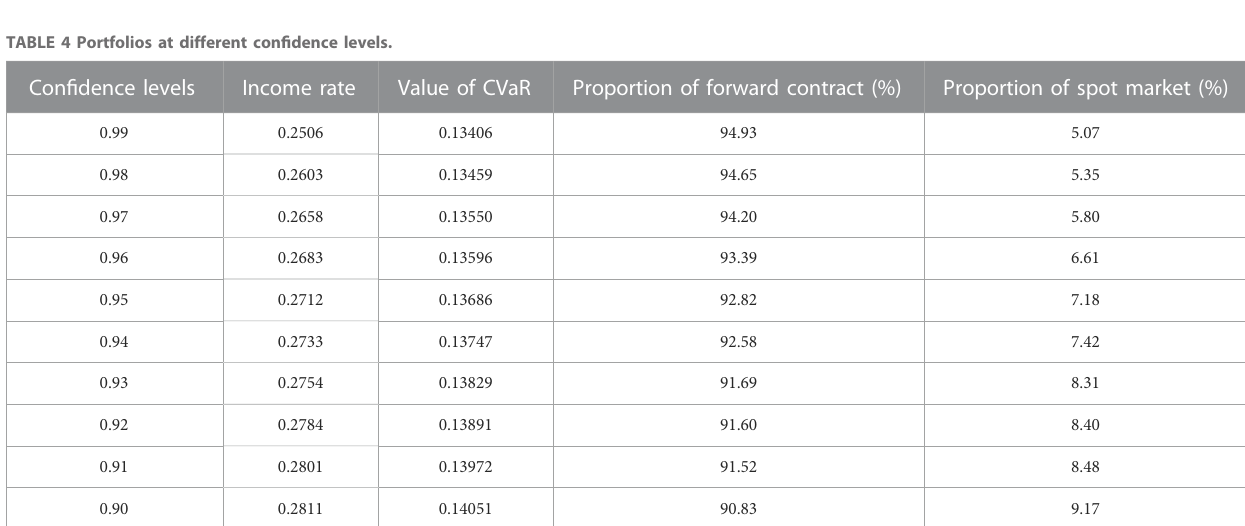
Figure 3. The Pearson correlation coef fi cient for the local and inter-provincial forward contract price is 0.017, indicating no linear correlation between the two. The Pearson correlation coef fi cient for the local and inter-provincial spot market price is − 0.812, indicating a strong negative correlation between the